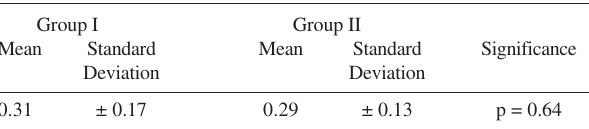
Table 5 - Comparison of Snellen Functional Acuity Equivalent (decimal value).